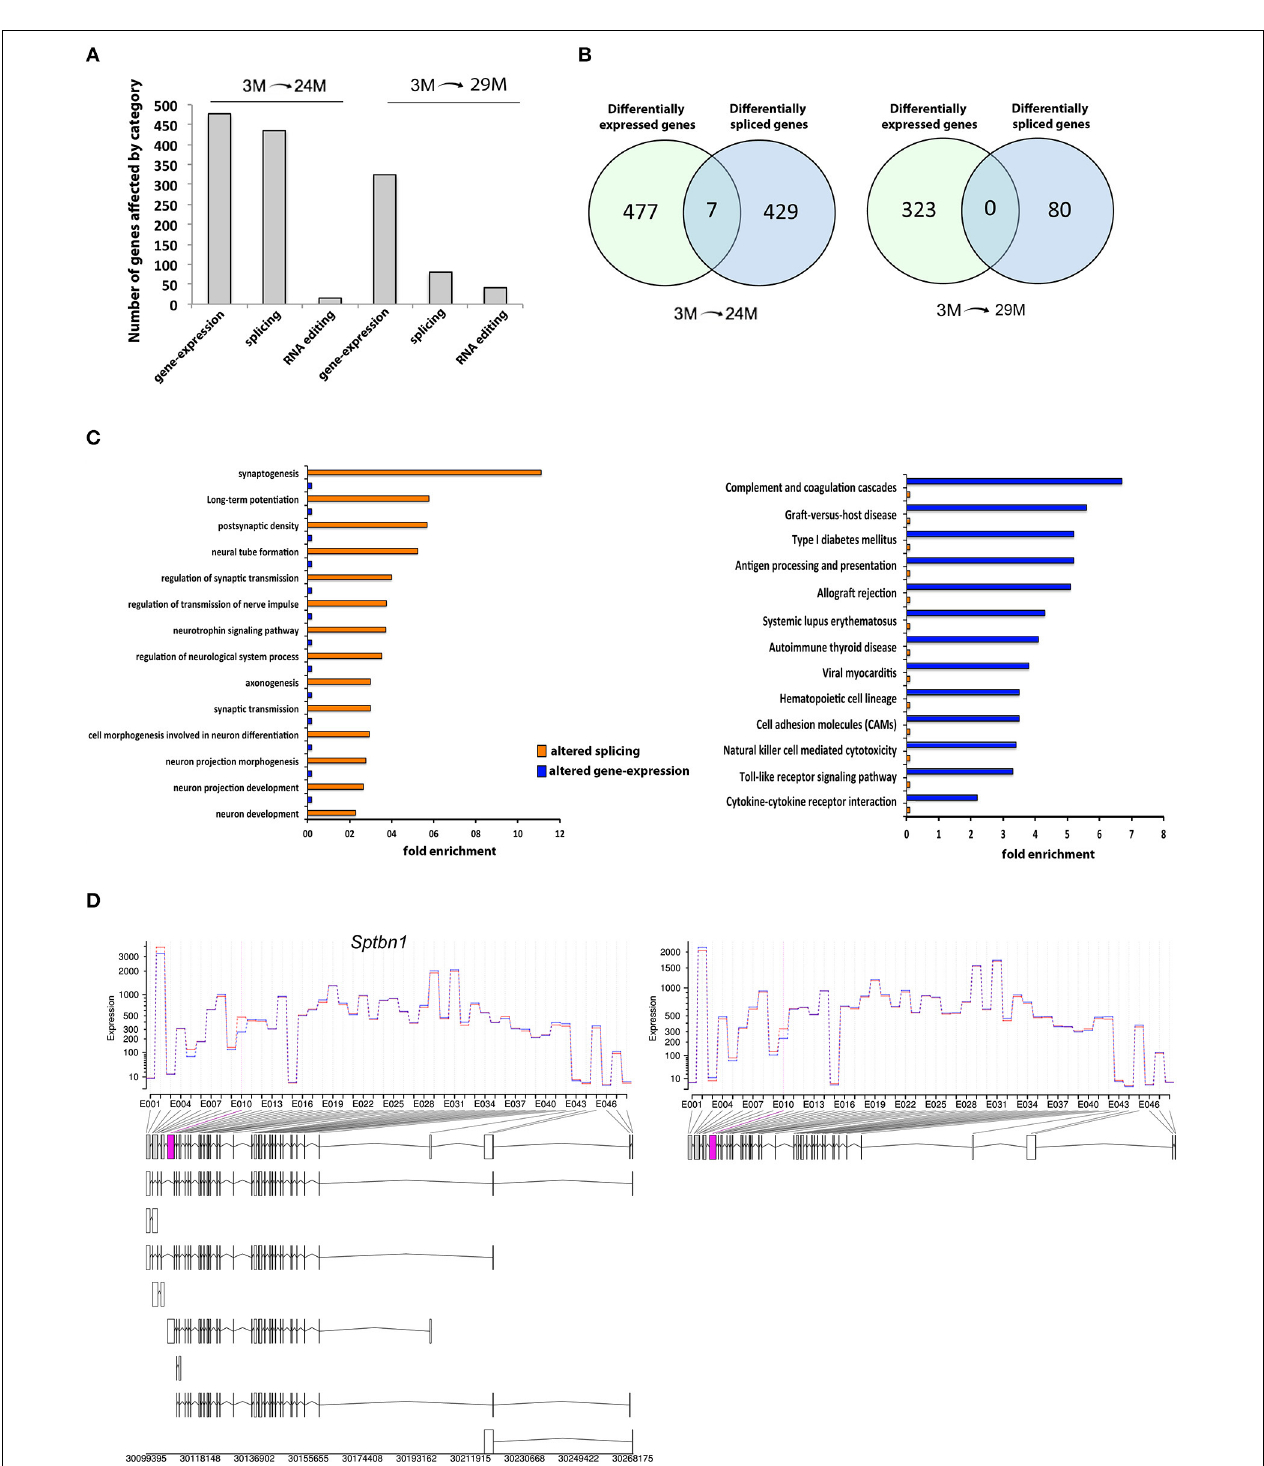
FIGURE 4 | Differential exon usage and alternative splicing changes. (A) Number of hippocampal genes affected by differential expression, splicing or RNA-editing during aging. (B) Venn-diagrams showing the overlap of genes affected by expression and/or splicing between age groups. Note that there is little to no overlap. (C) Cellular pathways affected in 3- vs. 24/29-month-old mice by splicing or expression